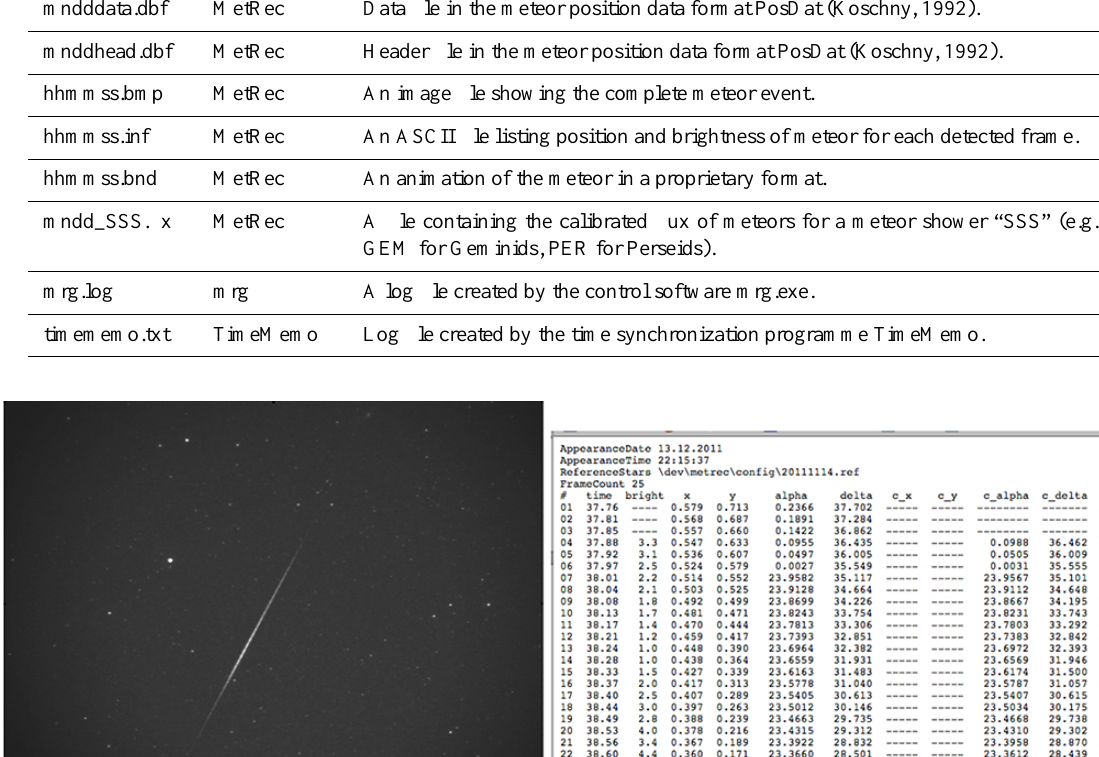
continuously produced. The viewing geometry in space is computed from the pointing direction of the camera. Assum- ing typical values of the magnitude distribution for shower meteors, the flux of the particles in km − 3 s − 1 is computed. The data are uploaded regularly to the beta version of the MetRec FluxViewer at http://vmo.estec.esa.int/flx. The actual sum image itself is also typically used for sci- entific analysis (e.g. to get a continuous light curve of the meteor). An example image and the corresponding *.inf file is shown in Fig.